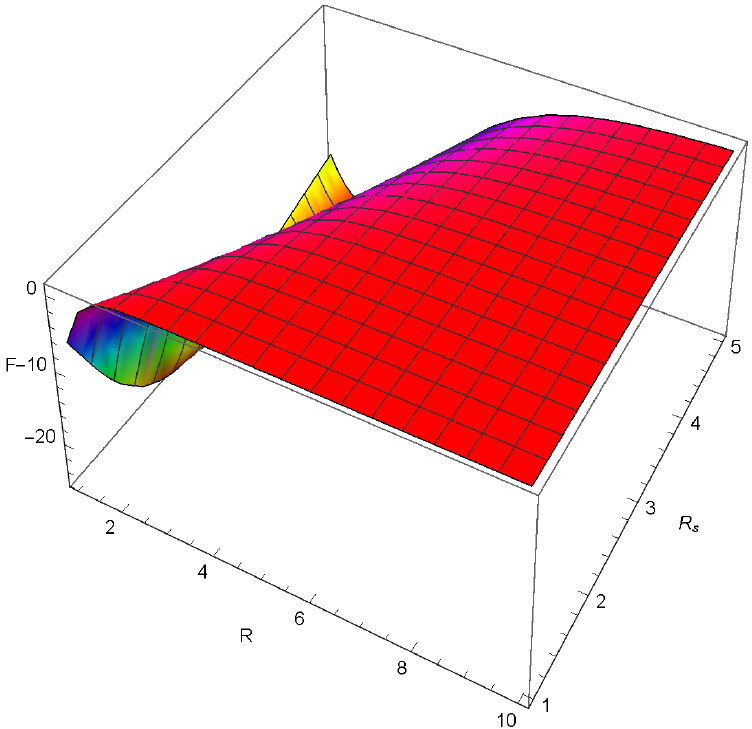
Figure 27. Solution of F ( R ( r )) for n = 3. The evolution of partial derivative of f ( R ) is obtained using Equations (33) and (44). The scalar potential for this model is: